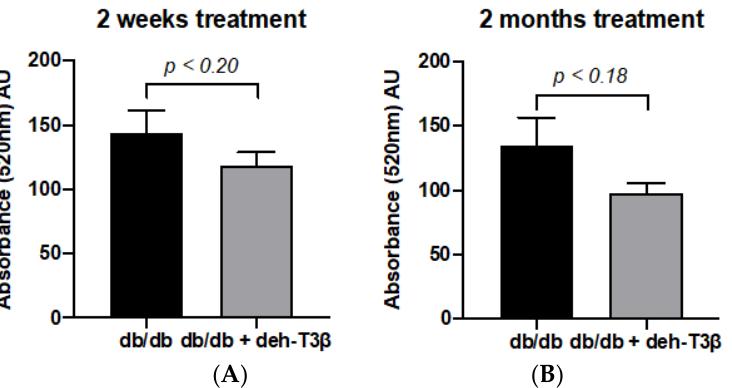
Figure 12. Mitochondrial swelling in kidneys of db/db mice. Each column represents mean values ± SD. db/db control mice (n = 5) compared to deh-T3β-treated mice (n = 5) after ( A ) 2 weeks’ and ( B ) 2 months’ treatment. p < 0.18. SD. db/db control mice (n = 5) compared to deh-T3 β -treated mice (n = 5) after ( A ) 2 weeks’ and ( B ) 2 2 months’ treatment. p < months’ treatment. p < 0.18.